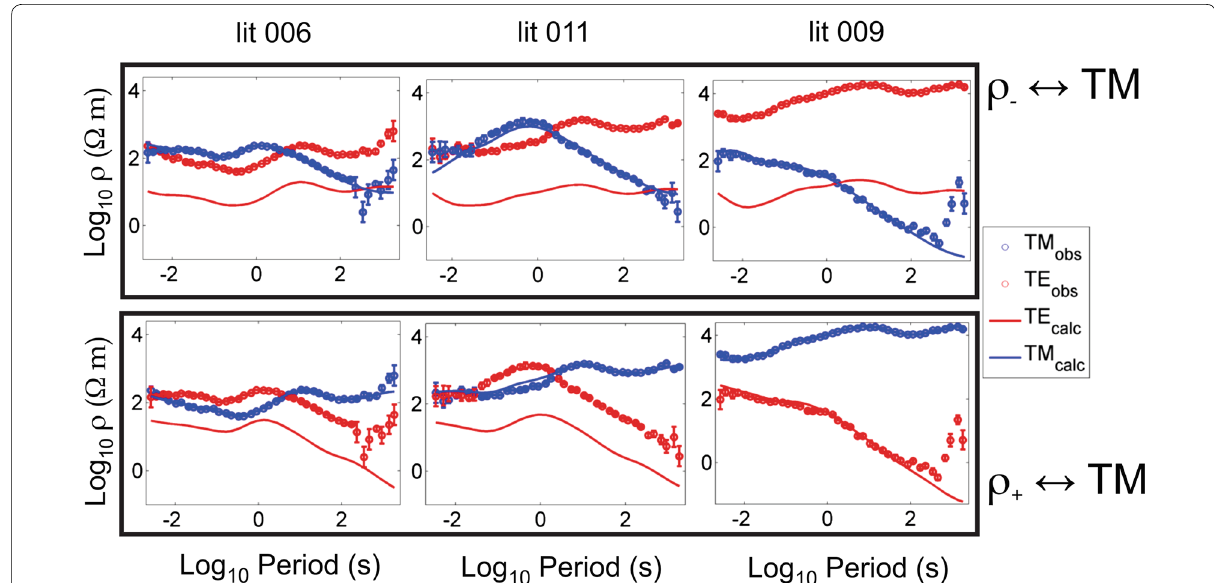
Fig. 10 The effect of leaving the TE apparent resistivity curves out of the inversion process is that the computed TE curves of the roughest models are approximately parallel to the field curves. It can be observed that the shifts for the three sites shown are far larger when assuming that ρ TM resistivity than when assuming that ρ is the TM resistivity +